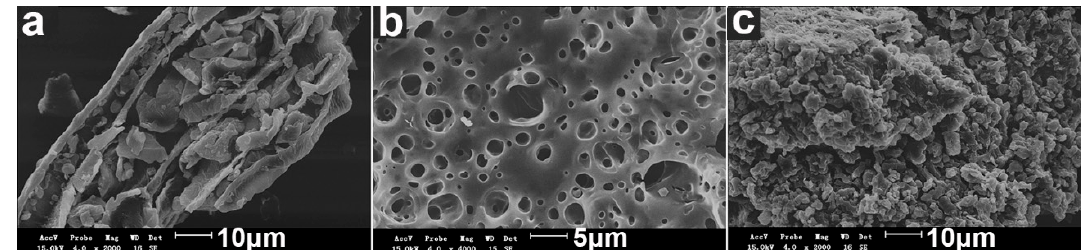
Figure 2. SEM images of the surfaces of ( a ) SD; ( b ) PAA, and ( c ) SD-PAA.